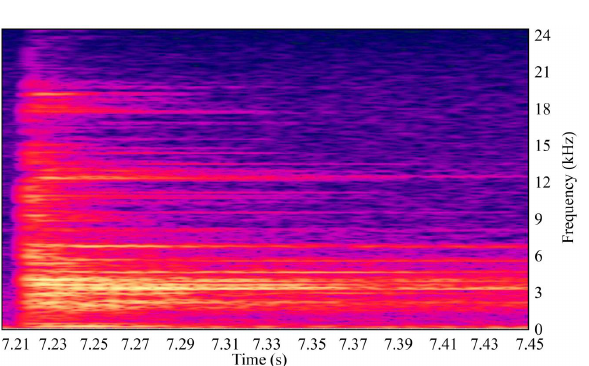
Fig. 3. Detailed view on the fourth response